Question: Give a one-sentence summary of this figure.
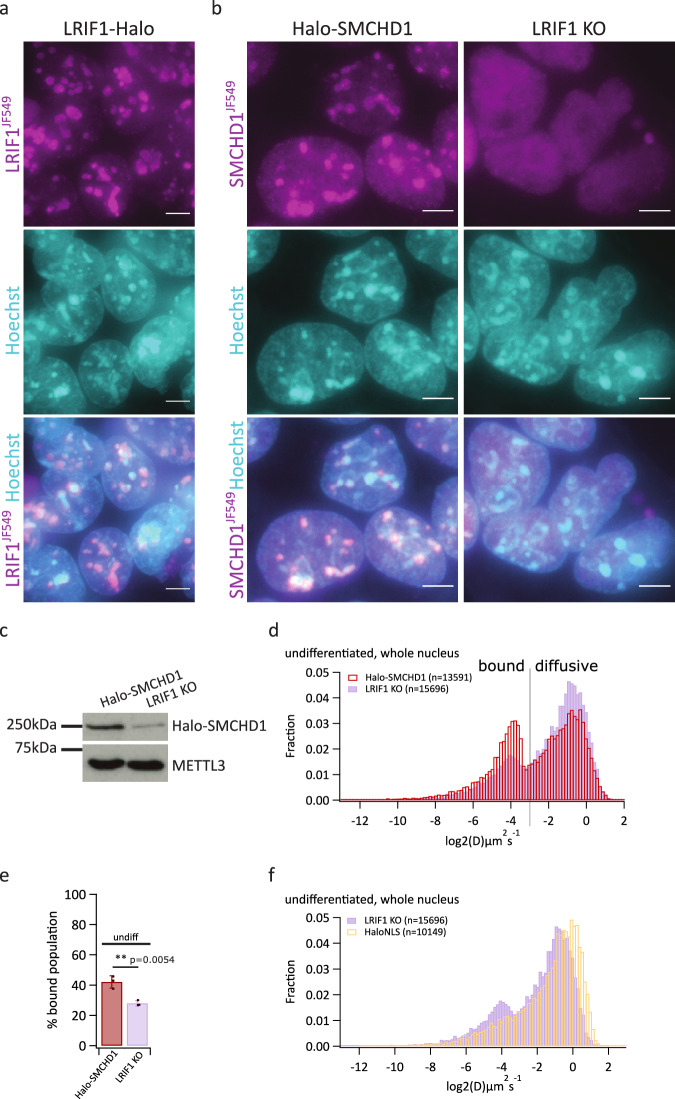
Answer: LRIF1 is required for SMCHD1 binding to chromatin in mESCs. a Representative live-cell images of LRIF1-Halo mESC line, taken 24 h after doxycycline addition. (two independent replicates) b Representative live images of Halo-SMCHD1 and Lrif1 -/- (LRIF KO) mESC lines. (three independent replicates) c Western blot showing SMCHD1 protein levels in the presence and absence of LRIF1 (three independent replicates). d Normalised histogram of diffusion coefficients of tracks from across the whole nucleus. Cells were undifferentiated, kept for 24 h with doxycycline. e Bar plots showing the average percentage of bound molecules of SMCHD1 (3 independent replicates each). Error bars represent the STDEV. Statistical analysis was by two-sided unpaired t-test. f In purple, same as in 2 d. In yellow, normalised histogram of diffusion coefficients of tracks from across the whole nucleus; cells are undifferentiated Halo-3xNLS mESCs, kept for 24 h with doxycycline. All images are maximum-intensity projections. Scale bars correspond to 5 µm. undiff = undifferentiated. Source data are provided as a Source Data file.